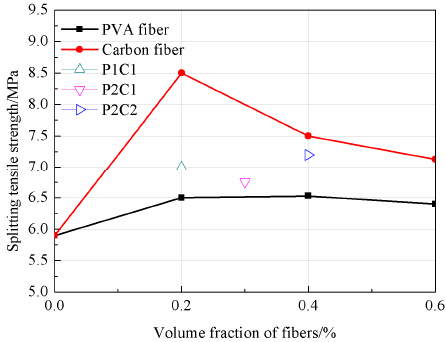
Figure 3. The tendency of the splitting tensile strength.